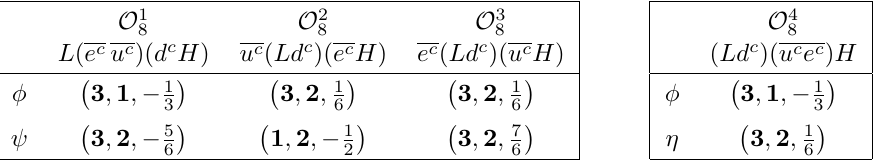
. Fields (cid:30) and (cid:17) are scalars, while the O 8